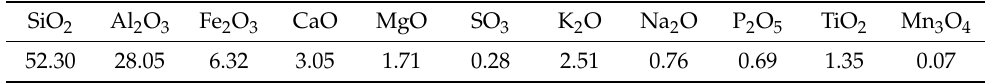
Table 1. XRF analysis of fly ash (FA).